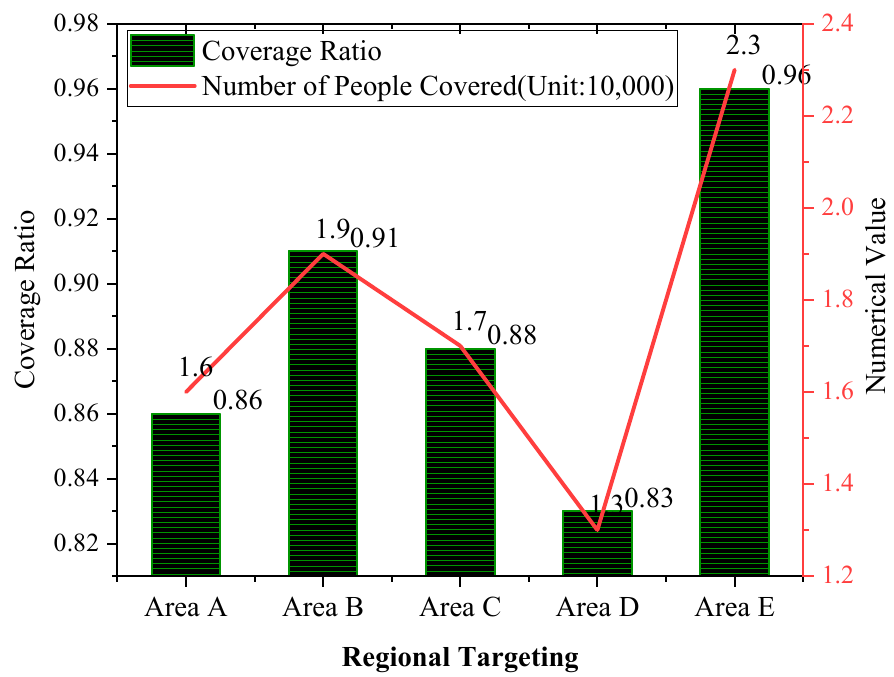
Figure 7. Healthy city residents’ community healthy service coverage.